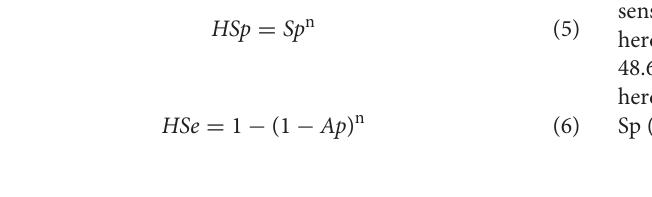
TABLE 1 | Animal and herd level CBPP seroprevalence by district in North Gondar zone, Ethiopia. District Animal level Herd level No. of animals No. of positive Apparent sampled animals prevalence (95% CI)